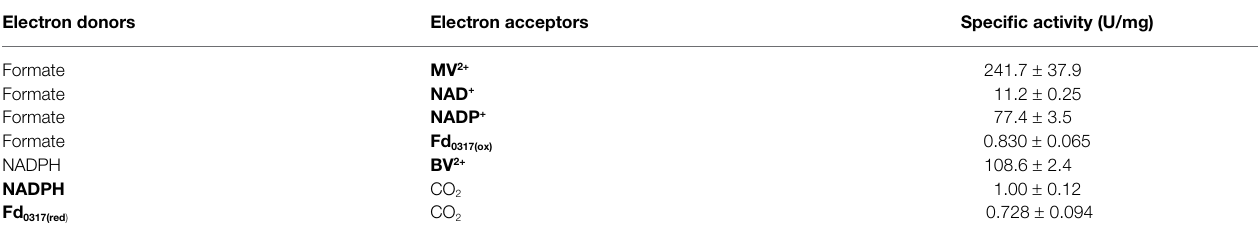
TABLE 2 | Specific activities of purified Fdh3 from Thermococcus onnurineus